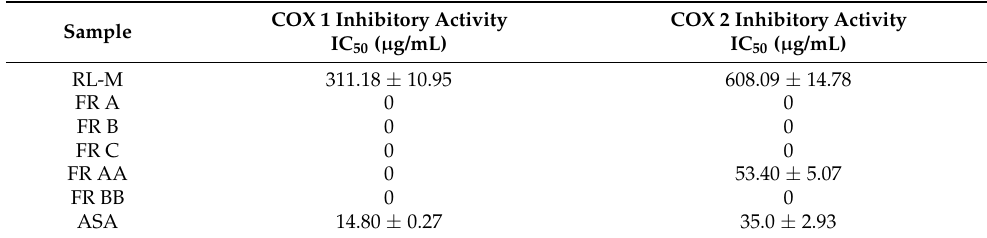
Table 2. Anti-inflammatory activity of Rhododendron luteum Sweet leaf samples. The inhibitory effects on cyclooxygenase 1 (COX 1) and cyclooxygenase 2 (COX 2) were expressed as IC 50 (concentration of the sample ( µ g DE/mL) which produces 50% of COX inhibition). Abbreviations: ASA – acetylsalicylic acid, other abbreviations as in Table